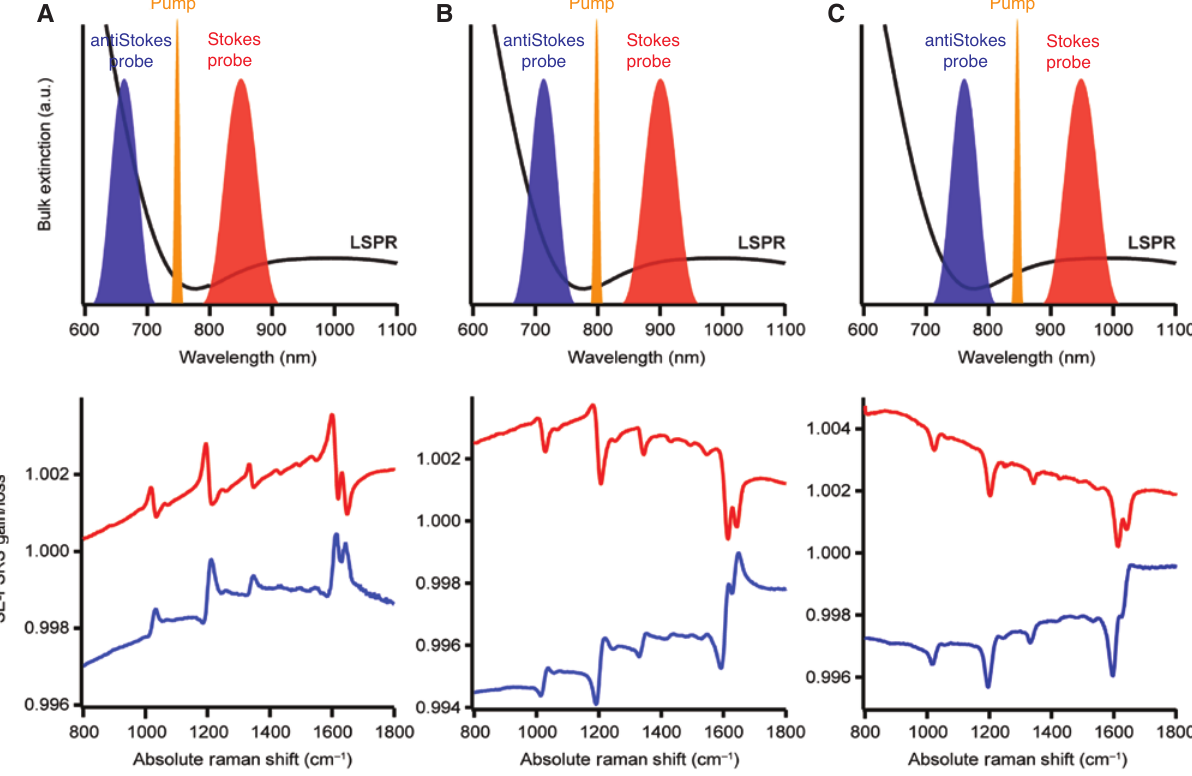
Figure 15: Broadband SE-SRS spectra of bipyridyl ethylene pumped at different wavelengths relative to the spectral resonance of a gold dumbbell